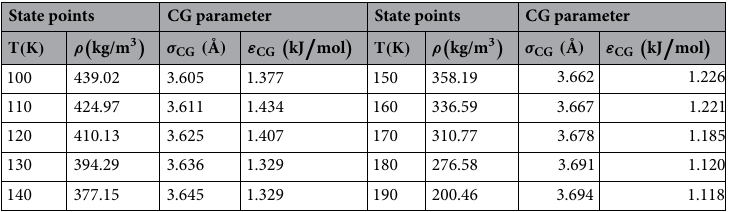
Table 2. The corresponding details of CG methane potential